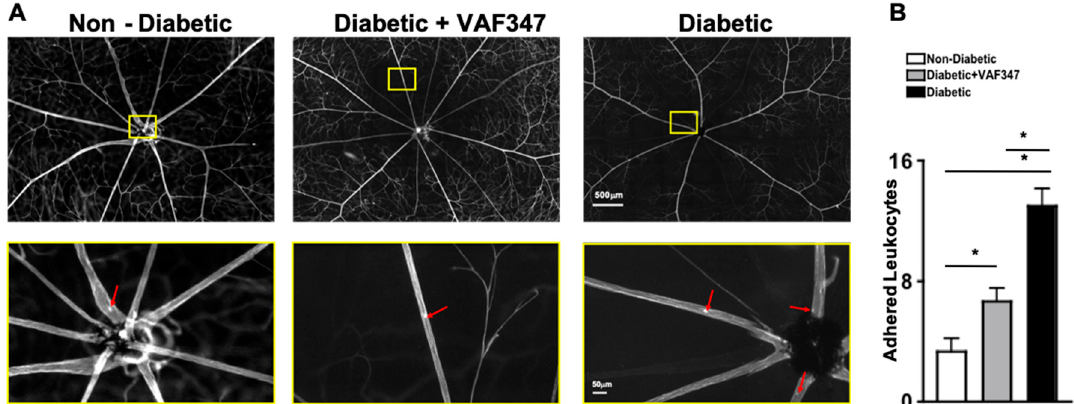
Figure 2. Leukostasis in the retinal vasculature of STZ-diabetic mice. ( A ) Representative images of leukostasis in the retinas of non-diabetic, VAF347-treated diabetic, and untreated diabetic C57BL/6 mice; following perfusion and staining. Total adherent leukocytes are shown in the upper quadrants, while the lower quadrant displays magnified sections, with red arrows highlighting leukocytes adhered to the retinal vasculature. ( B ) Quantification of the number of leukocytes adhered to the retinal vasculature in all mice ( n = 3/group). Scale bars = 500 μ m (upper quadrant) and 50 μ m (lower quadrant) are displayed as a visual indicator of the size of the representative image. * = p < 0.01; p -value was first equated by two-way ANOVA and then an unpaired t -test with Tukey’s post-hoc analysis.